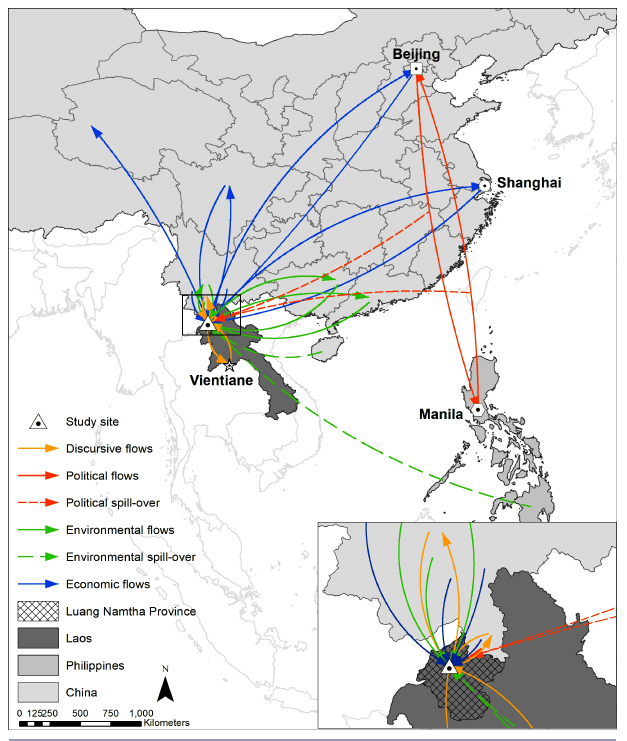
Fig. 3. Sketch of the flows involved in the four telecouplings driving the expansion of banana plantations in Luang Namtha Province, Lao